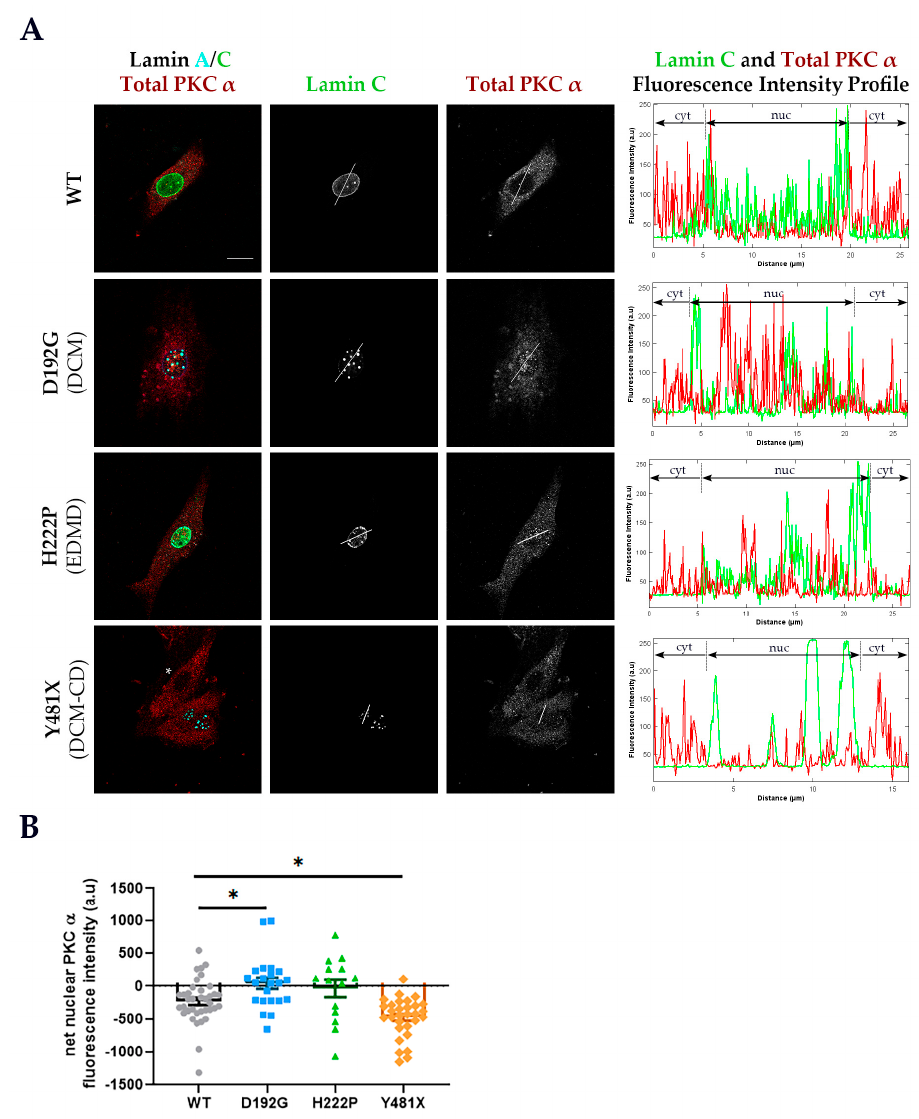
Figure 2. Cellular localization of total PKC- α in transfected H9C2 cells expressing either WT or mutant human lamins A and C. ( A ) Exogenous eCFP-human lamin A and eYFP-human lamin C are shown with the immunostaining for endogenous PKC- α (red) in WT and mutant LMNA expressing H9C2 cells. The composite image showing total PKC- α , eCFP-human lamin A and eYFP-human lamin C for each group is shown in the leftmost panel. A representative untransfected cell (indicated by a white asterisk) shows cytoplasmic PKC- α localization comparable to PKC- α localization in WT LMNA transfected cells. The white line across a cell in the lamin C and total PKC- α panels indicates the measurement path used to generate the fluorescence intensity profiles for lamin C and PKC- α shown in the rightmost panel. Since lamins A and C colocalize, the plot profile for eYFP-human lamin C only is included to show nuclear demarcation of fluorescence signal. Scale bar: 15 µ m for all immunofluorescence images. ( B ) Mean ( ± SEM) net nuclear PKC- α fluorescence intensity of each group: WT (grey circles), D192G (blue diamonds), H222P (green triangle) and Y481X (orange diamonds) . The net nuclear PKC- α fluorescence intensity of each cell = adjusted nuclear PKC- α fluorescence intensity − mean of the adjusted cytoplasmic PKC- α fluorescence intensities. n ≥ 3 independent sets were analyzed ( ≥ 14 cells / group are analyzed). Significance (*) was set at p <